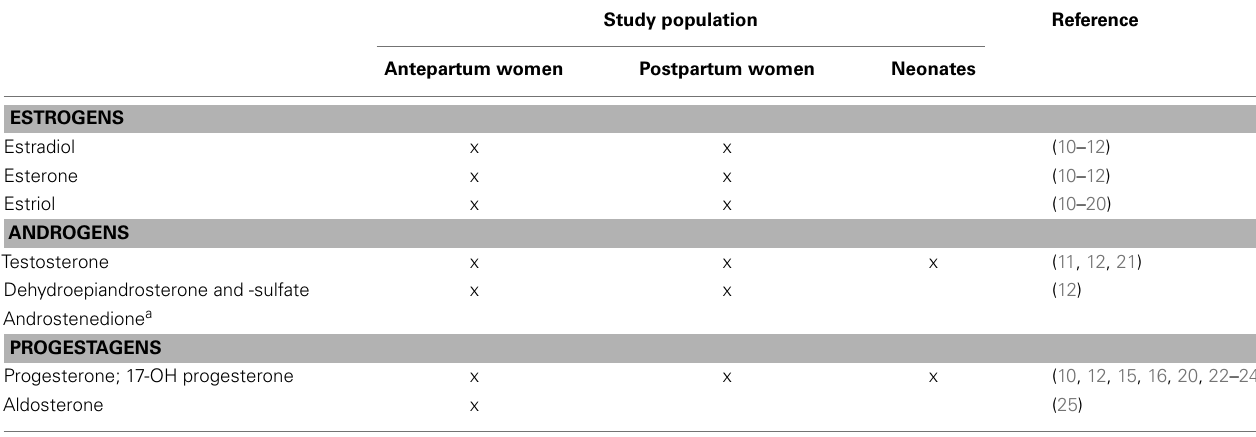
Table 2 | Gonadal steroid salivary analytes of interest to developmental science and past human studies utilizing salivary assessment in the prenatal and neonatal